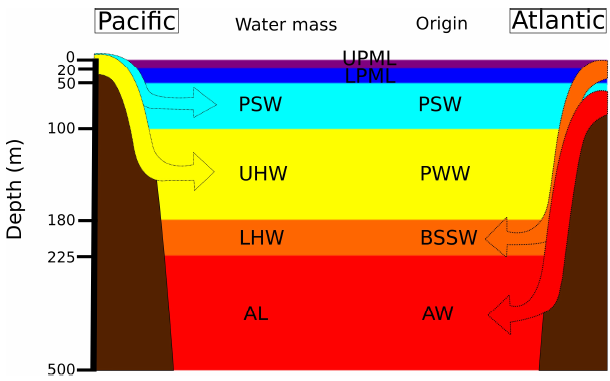
Fig. 2. A schematic image of water masses of the Arctic Ocean. The different water masses correspond to different colors as in Figs. 5 and